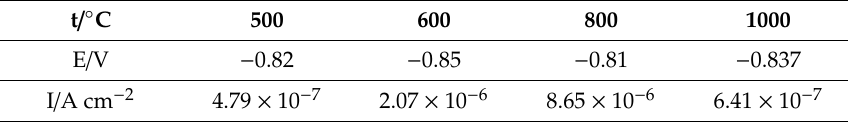
Figure 8. Polarization curve at the interface. Table 2. Corrosion potential and current at the interface.